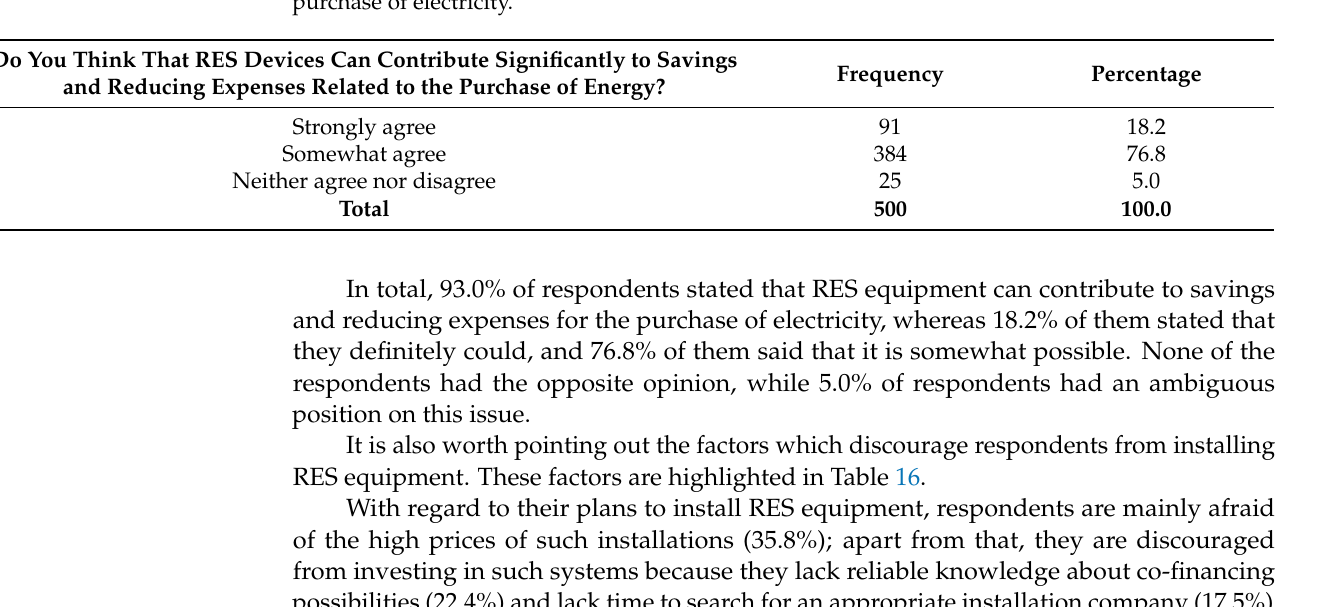
Table 15. Respondents’ opinions on the impact of RES systems on reducing expenses related to the purchase of